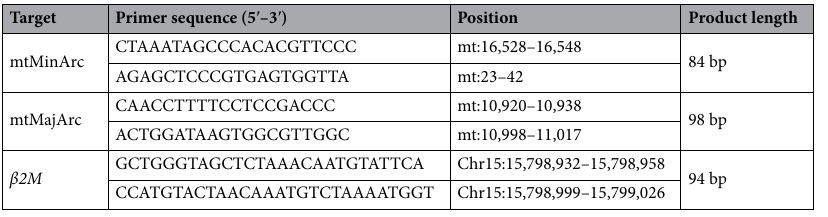
Table 1. PCR primers used in this